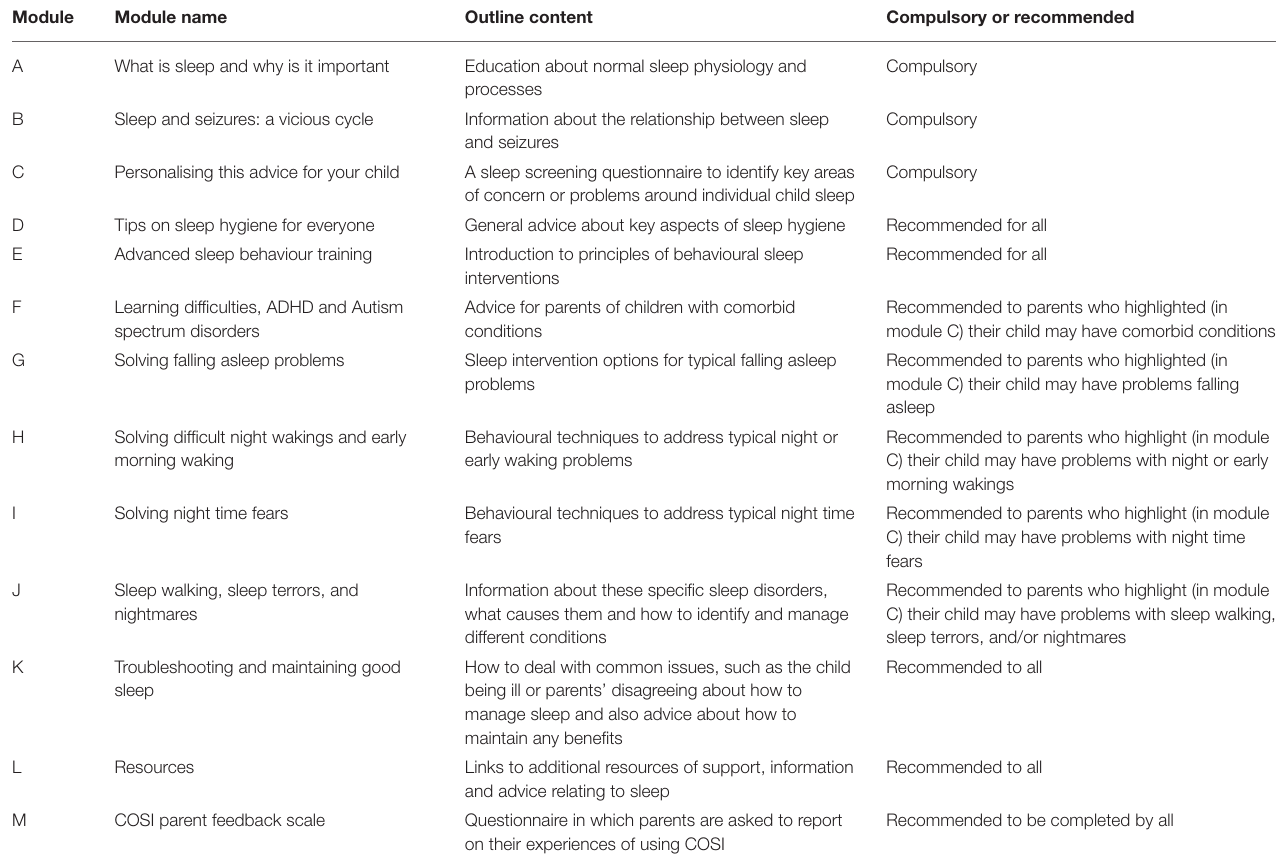
TABLE 3 | COSI module names, descriptions and compulsory or recommended